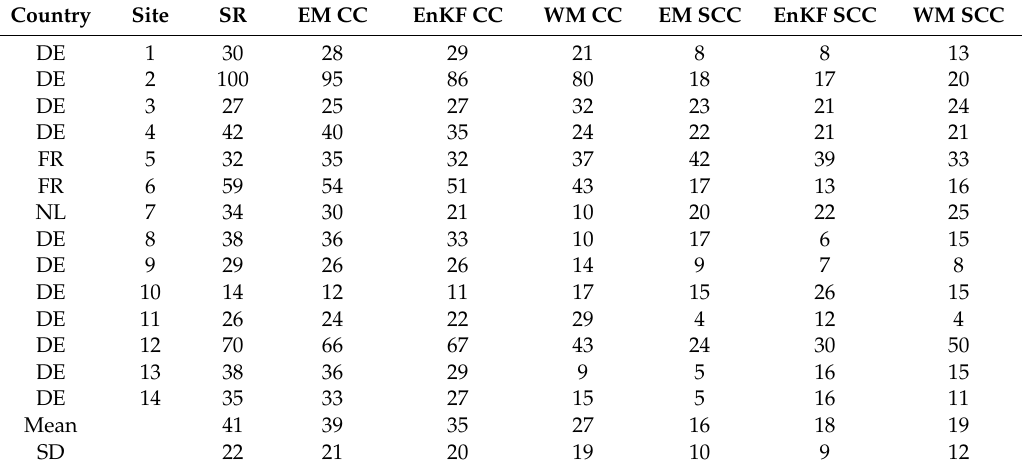
Table 6. MAPE results for grain yields (in %, per site). EnKF: Ensemble Kalman Filter, WM: Weighted Mean, EM: Ensemble Mean, CC: Crop Component Set, SCC: Soil and Crop Component Set. DE: Germany, FR: France, NL: Netherlands.